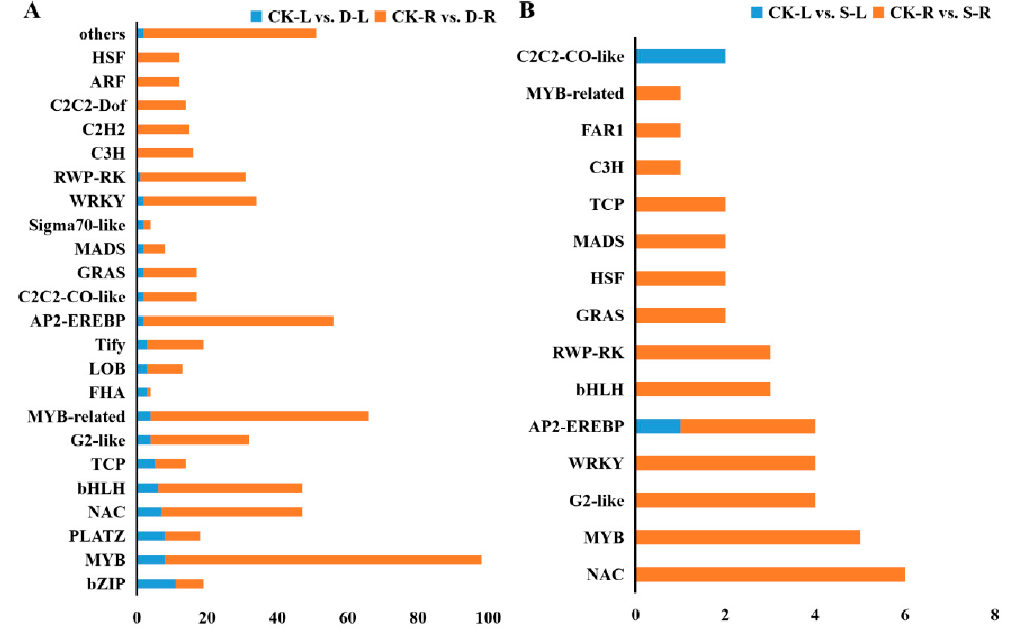
Figure 4. Differentially expressed transcription factors under drought or salinity stress in B. napus . Representative DEGs under ( A ) drought stress and ( B ) salinity stress, respectively. CK-L (CK, leaves) vs. D-L (drought, leaves), CK-R (CK, roots) vs. D-R (drought, roots), CK-L vs. S-L (salinity, leaves), CK-R vs. S-R (salinity, roots) represent DEGs under these two abiotic stresses. As far as proline metabolism, the promoters of DEGs encoding BnOAT (BnaA06g36140D), BnP5CS1 (BnaA03g18760D, BnaA05g05760D, BnaC03g72600D, BnaC04g05620D), and BnP5CS2